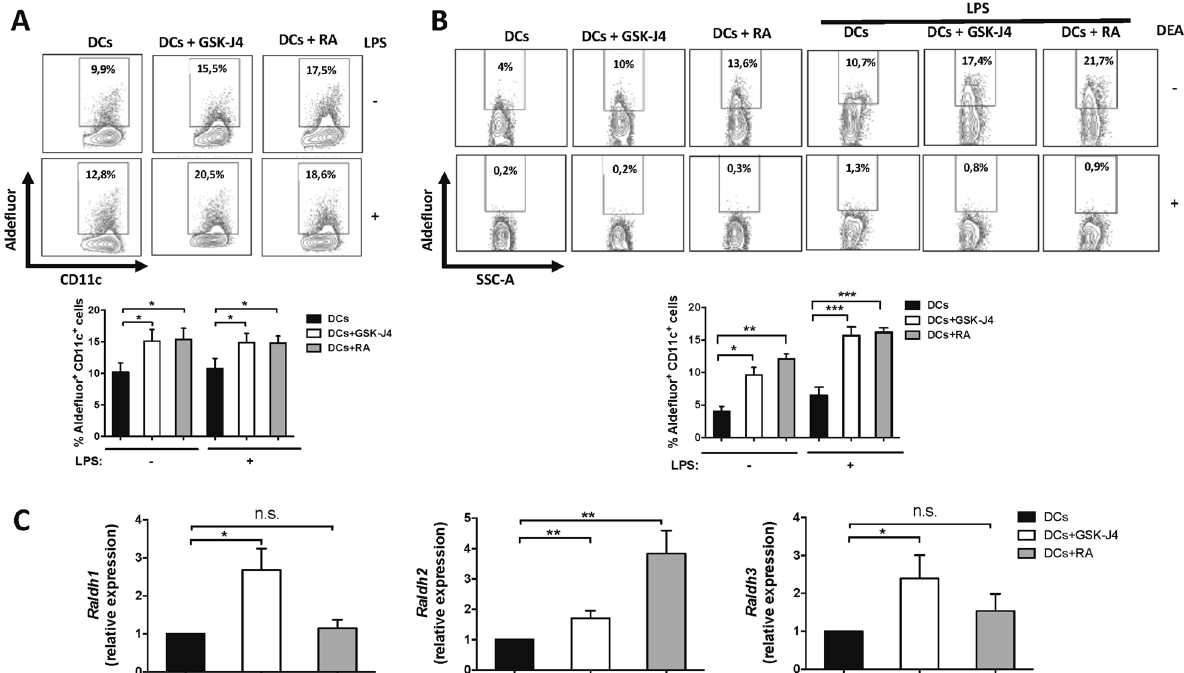
Figure 4. GSK-J4 promotes RALDH activity in DCs isolated from spleen or MLN. (A-B) CD11c + DCs were isolated from the MLN ( A ) and the spleen ( B ) and either unstimulated or stimulated with 100 ng/mL LPS in the presence or absence of 25 nM GSK-J4 or 10 nM RA for 16 h. Top panels show representative dot-plots of RALDH activity using Aldefluor assay. Numbers represent the frequencies of cells in the corresponding quadrant. Bottom panels show the frequency of Aldefluor + cells from the CD11c + gate obtained from at least six independent experiments. ( C ) Splenic CD11c + DCs from C57BL/6 mice were stimulated with 100 ng/mL LPS in the presence or absence of 25 nM GSK-J4 for 16 h. RT-qPCR analysing raldh1 (left panel), raldh2 (middle panel), and raldh3 (right panel) expression were performed on DCs. Relative expression levels were normalized using 18S RNA as control. Data represent mean ± SEM from six independent experiments. * p < 0.05; ** p < 0.01; *** p < 0.001 as determined by one-way ANOVA followed by Tukey’s post-hoc test ( A – C ). n.s., not significant differences were